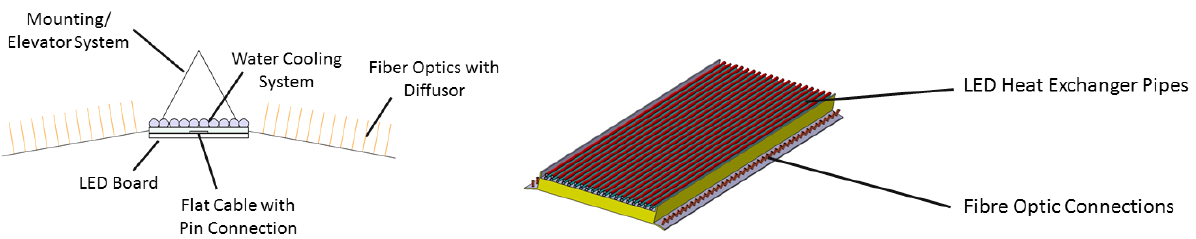
Figure 15: Schematic front view of light panels and CAD rendering of the light